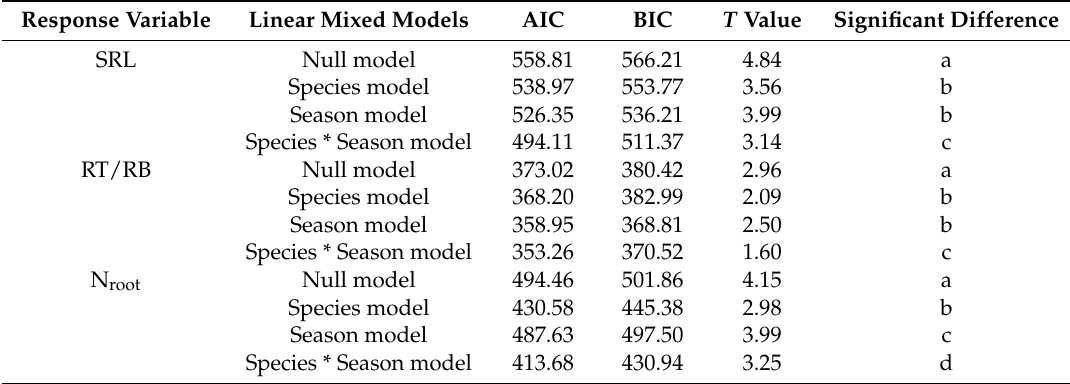
Table 3. Effect of seasons on specific root length (SRL), root tips over the root biomass (RT/RB), and N concentrations (N root ) in fine roots of the four study plant species in a karst ecosystem of southwest